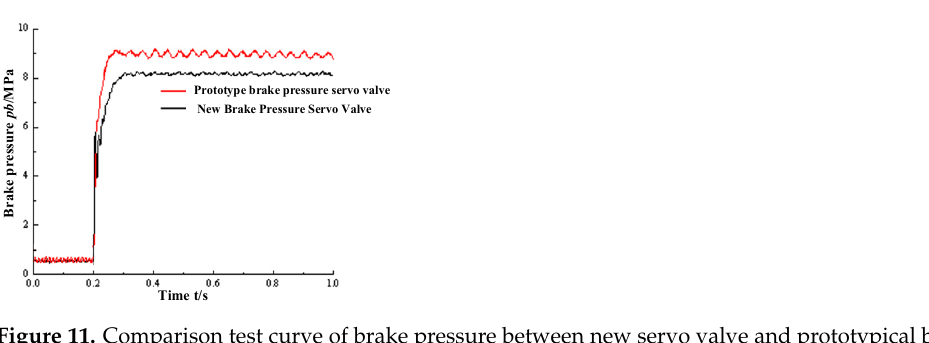
Figure 11. Comparison test curve of brake pressure between new servo valve and prototypical brake servo valve.